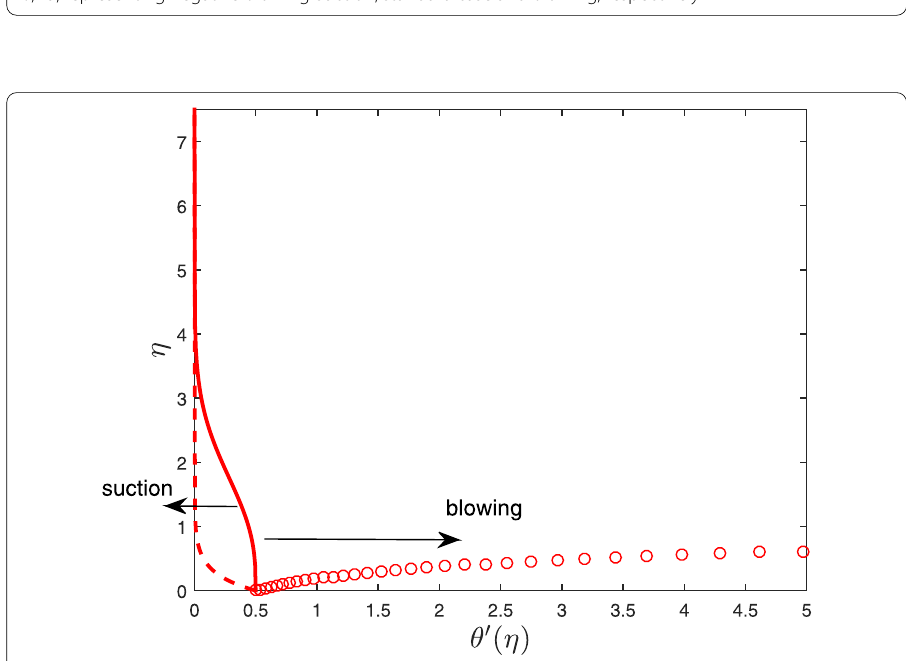
Fig. 5 Effect of normal mass flux blowing on the dimensionless heat flux θ ’, from left to right: f w 0, ‐ 5, representing negative blowing-suction, standard case blowing,